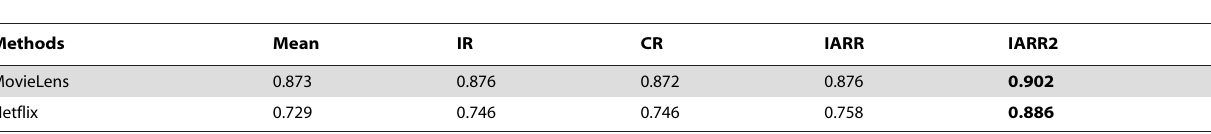
Table 2. AUC values of different algorithms for the real-data sets.